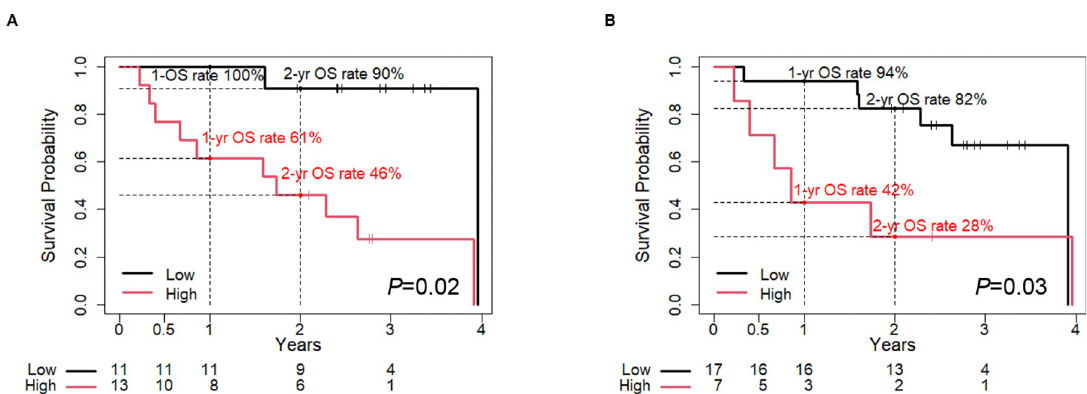
Fig 3. Correlation between high expression of PODXL and ITGB1 and poor outcomes of PDAC patients. (A, B) Kaplan-Meier analysis of postoperative OS rates according to (A) PODXL expression and (B) ITGB1 expression in PDAC tissues obtained by